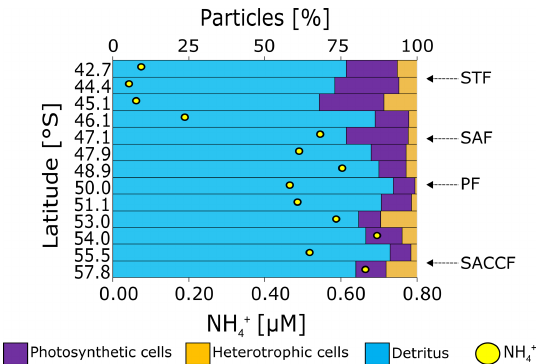
Figure 7. Relative contributions of photosynthetic, heterotrophic bacterial, and detrital particles to the total flow cytometry counts at the surface during leg S. The coincident NH + shown as yellow dots. Abbreviations are as in Fig.